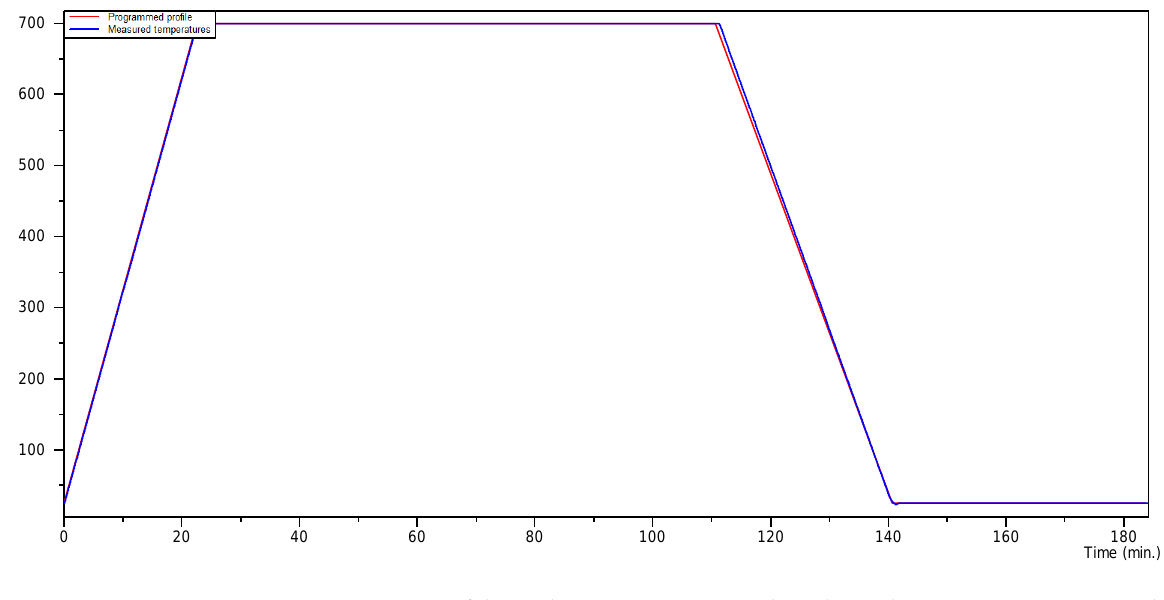
Figure 4. Parameters of the oxidation process in a single cycle: oxidation temperature 700 °C, heating rate 60 °C per min, holding time 90 min, cooling rate 23 °C per min.